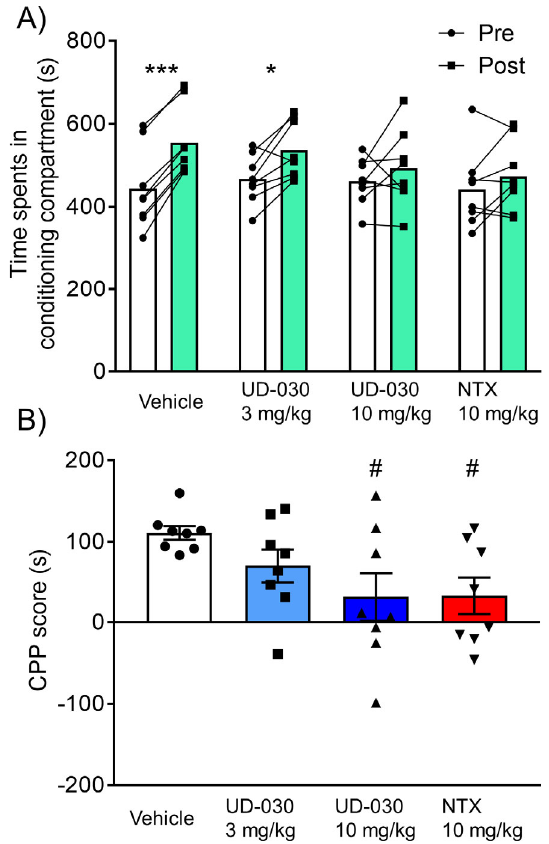
Figure 4. Inhibitory effect of UD ‐ 030 on the expression of morphine ‐ induced conditioned place pref ‐ erence. ( A ) Time spent in the morphine (10 mg/kg, i.p.) ‐ paired compartment in the preconditioning phase (pre, white columns) and postconditioning phase (post, green columns). Mice ( n = 8/group) were pretreated with UD ‐ 030 (0, 3, and 10 mg/kg, p.o.) or NTX (10 mg/kg, p.o.) 60 min before the postconditioning phase. Lines that connect symbols represent the value of individual mice. Columns represent the mean. *** p < 0.001, * p < 0.05, difference between pre ‐ and postconditioning phases for each treatment. ( B ) Conditioned place preference (CPP) scores for each treatment. The columns and vertical lines represent the mean ± SEM. # p < 0.05, compared with vehicle ‐ pretreated (control) mice.